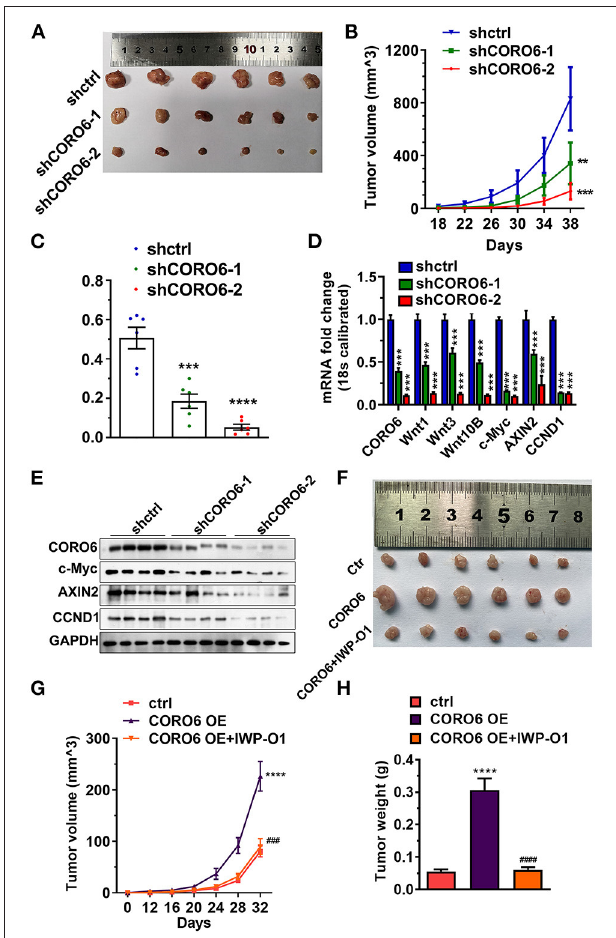
FIGURE 9 | Xenograft mouse model to support the oncogenic role of CORO6 in ccRCC development. (A–C) CORO6 depletion suppressed ccRCC tumor growth monitored by tumor size (A) , growth curve (B) , and tumor weight (C) . (D) The mRNA levels of c-Myc, AXIN2, and CCND1 were remarkably reduced in CORO6-depleted ccRCC tumors. The expression levels of detected genes were normalized to 18s rRNA. (E) Western blotting showed that the protein levels of c-Myc, AXIN2, and CCND1 were remarkably reduced in CORO6-depleted ccRCC tumors. GAPDH was used as the internal control. (F–H) CORO6-promoted ccRCC tumor growth was inhibited by the administration of IWP-O1 monitored by tumor size (F) , growth curve (G) , and tumor weight (H) . ** P < 0.01, *** P < 0.001, and **** P < 0.0001. Compared with CORO6 OE, ### p < 0.001 and #### p <